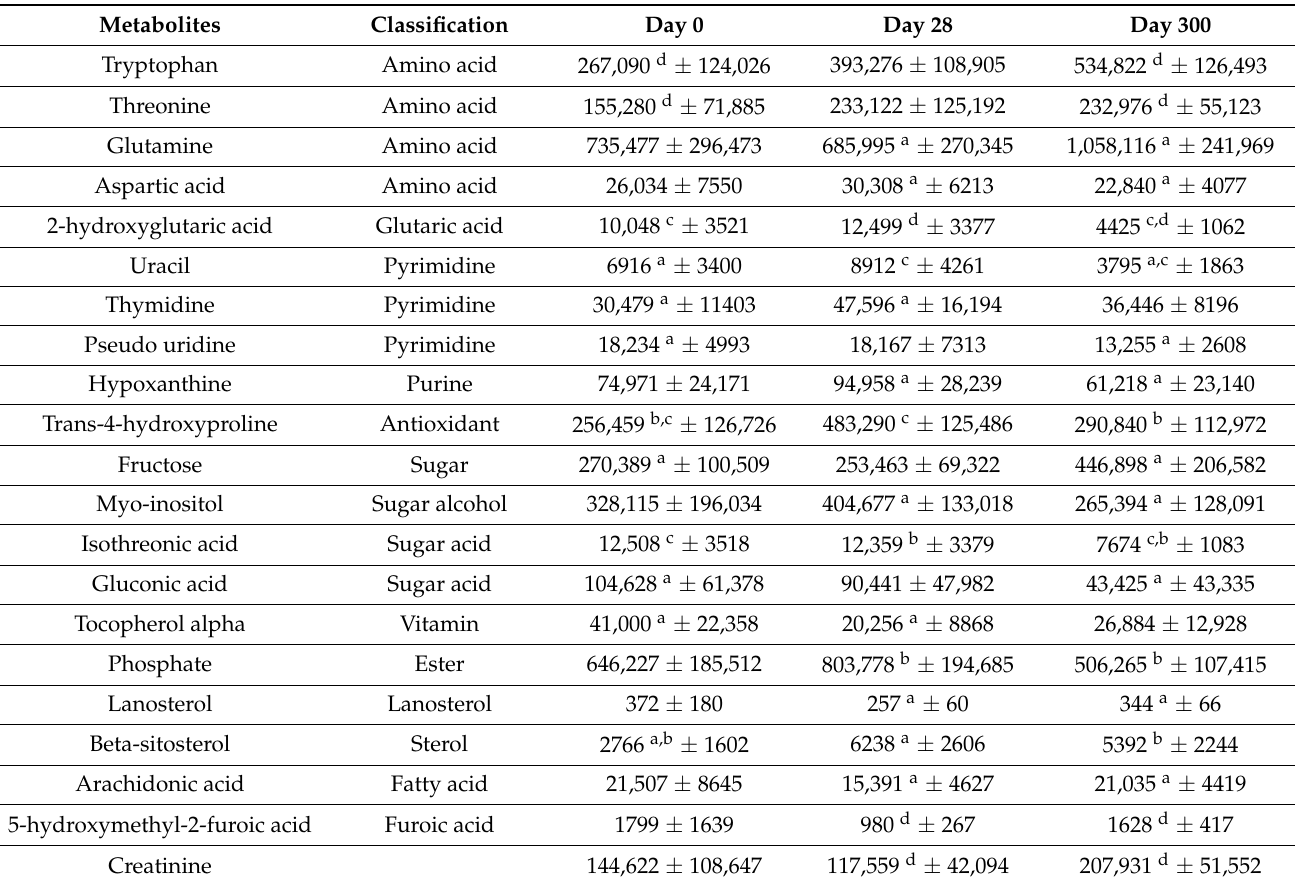
Table 4. Peak heights of serum metabolites that significantly differed over time within cats of the DOX